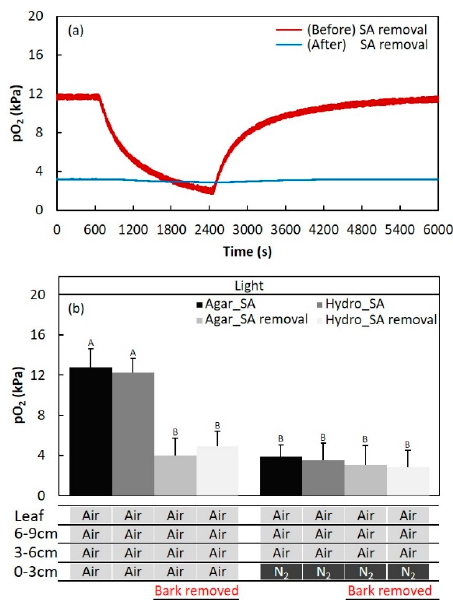
Figure 5. The effect of removal of secondary aerenchyma (SA) developed in the stem on the oxygen partial pressure (pO 2 ) in the adventitious roots of Syzygium kunstleri grown on hydroponic and agar media. ( a ) Time-trace of pO 2 in the adventitious roots before and after the removal of SA in the stem. N 2 was injected in exchange of air from 600 to 2400 s at the 0–3 cm-section of the stem above the water level. ( b ) A 1-cm-long section of bark (SA) was removed from the stem, located 2 cm below the water surface. Air or N 2 was injected at the 0–3-cm portion of the stem above the water level before and after SA removal. Values are means ± SD. ( n = 6 roots from 6 individual plants, average of the last one minute before changing the treatments). The same letter means no significant difference within the same area ( p < 0.05, one-way ANOVA, followed by Tukey’s test for multiple comparisons). Agar: agar medium, Hydro: hydroponic medium, and SA: secondary aerenchyma.